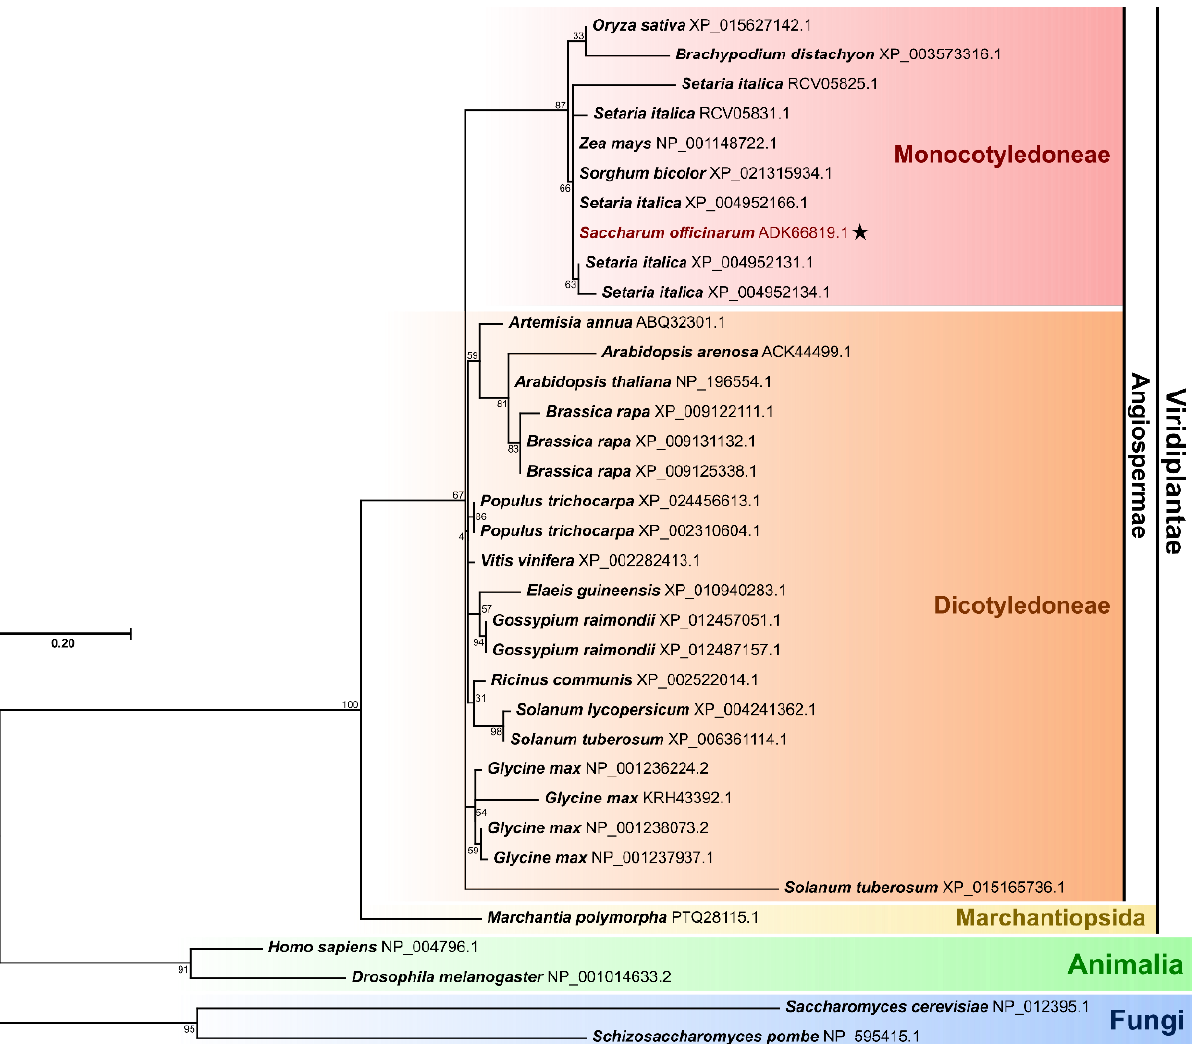
Figure 2. Rpb4 is conserved across kingdoms. Phylogenetic relationship of Rpb4 from plants (monocots, dicots, and bryophytes), animals, and fungi. Phylogenetic analysis was generated by the Maximum Likelihood method. A discrete Gamma distribution was used to model evolutionary rate differences among sites (5 categories (+G, parameter = 3.5673)). Numbers at the nodes represent the percent of bootstrap values based on 1000 replications.